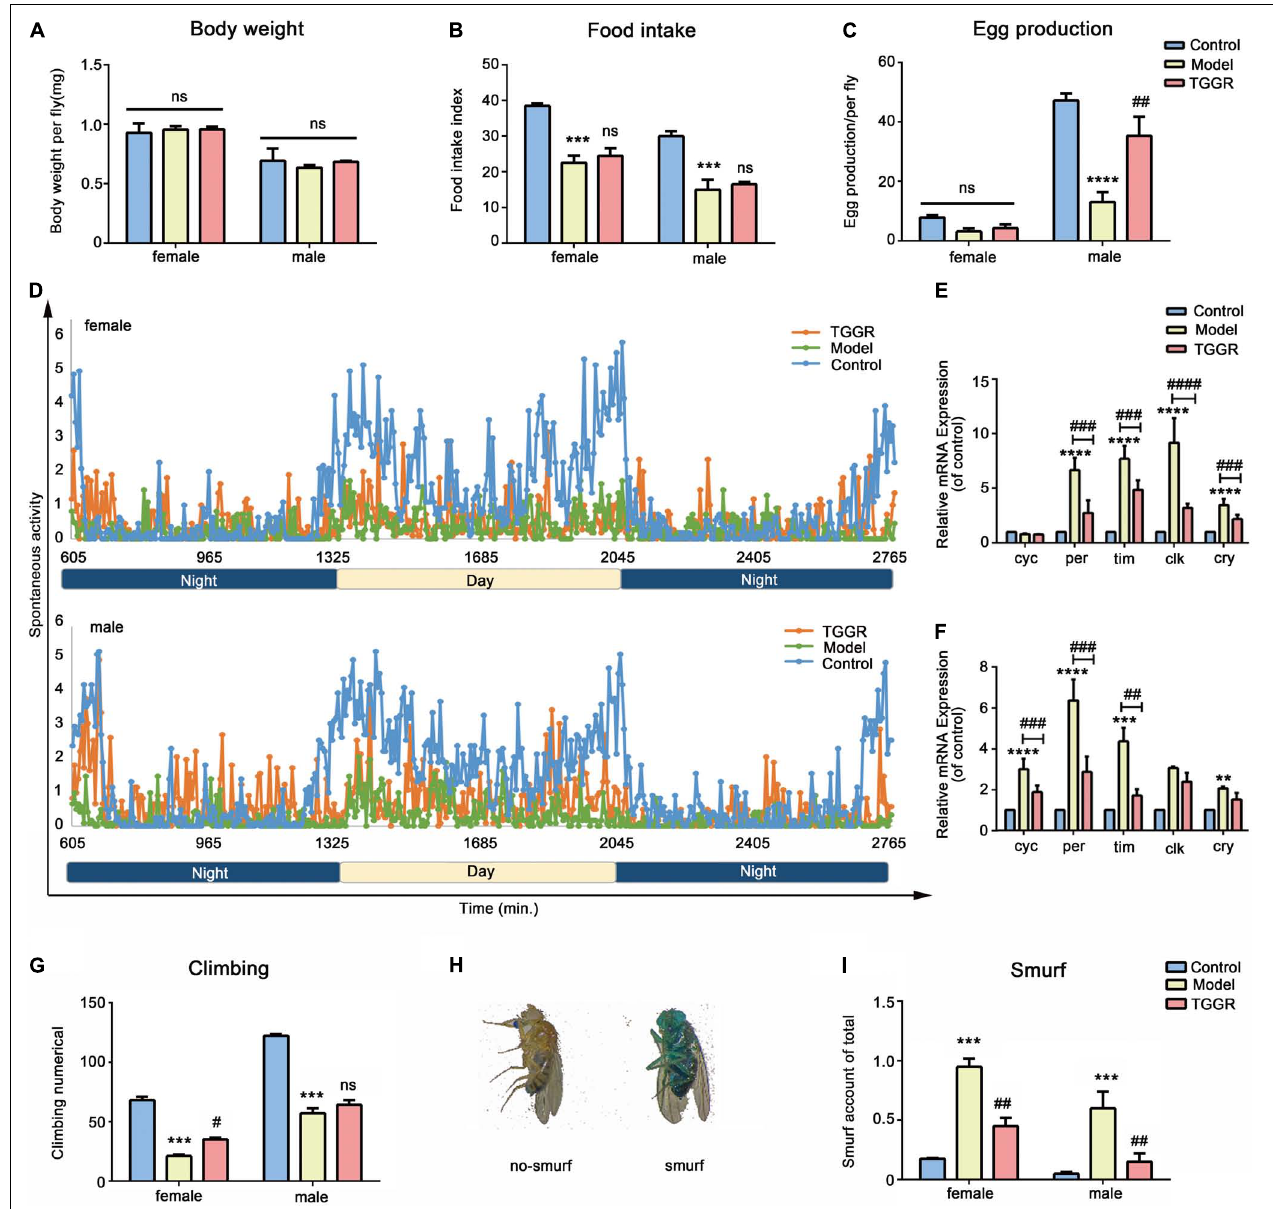
FIGURE 4 | TGGR treatment prolongs healthspan. Body weight ( A , N = 90 flies), feeding assay ( B , N = 60 flies), fecundity ( C , N = 60 flies), climbing numbers ( G , N = 90 flies), intestinal integrity ( I , N = 90 flies) with or without TGGR treatment. (D) Circadian rhythm of 40-day-old flies with or without TGGR treatment ( N = 16 vials of one fly per condition). mRNA levels of biorhythm genes were analyzed in flies with or without TGGR treatment for 40 days ( E: female; F: male). ( N = 90 flies per condition, two-way ANOVA). (H) Representative images of ‘Smurf’ and ‘no Smurf’ in Drosophila “Control” was 7-day-old flies, “Model” was 40-day-old flies,